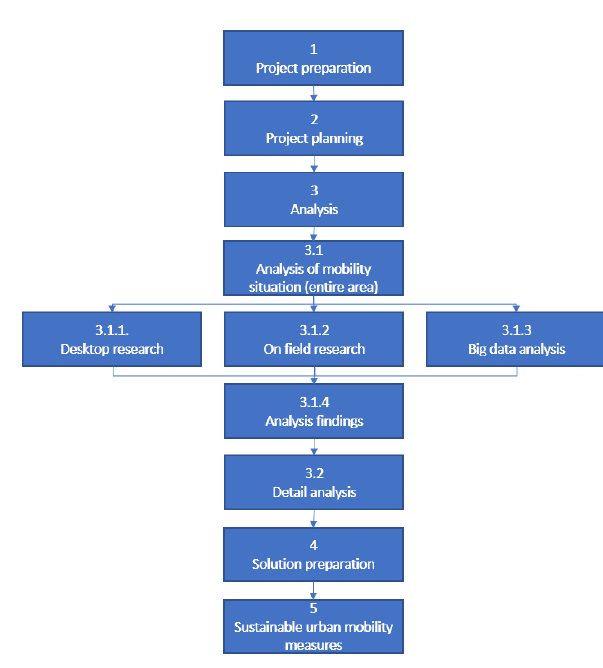
Figure 1. High level visualisation of SUMBooST toolbox methodology